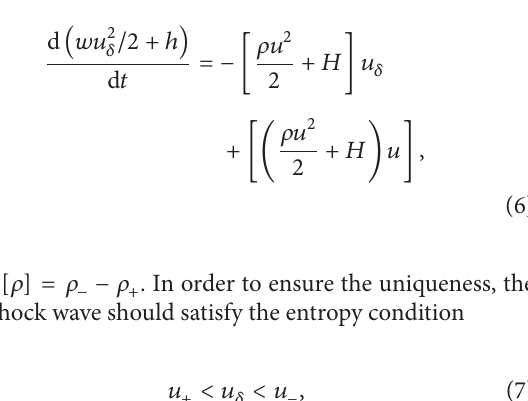
Figure 1: 𝑢 − > 𝑢 𝑚 > 𝑢 +